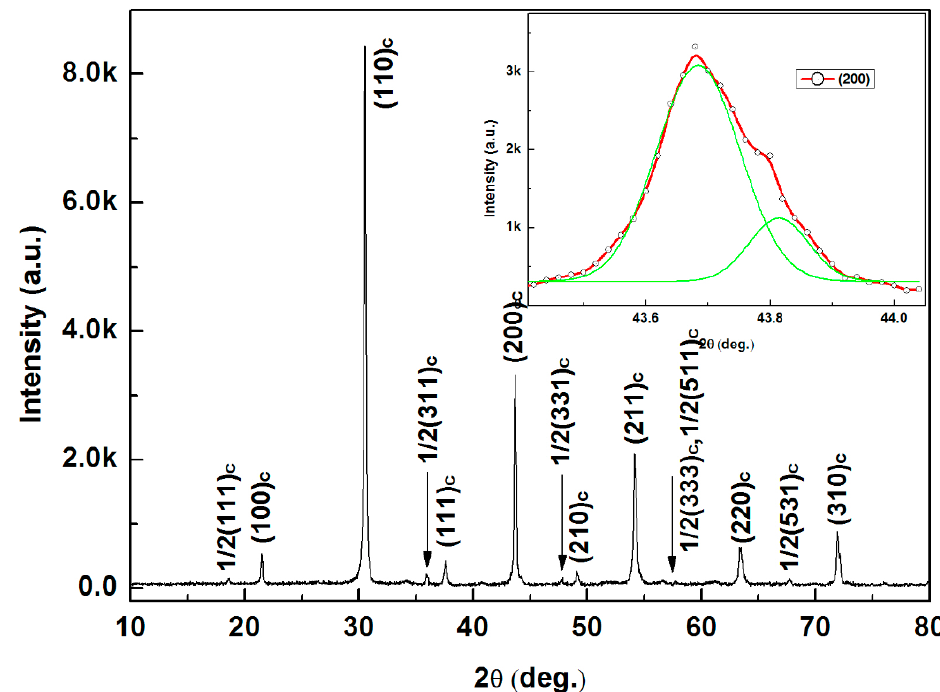
Figure 2. X-ray powder diffraction patterns of the crashed PLN-0.07PT crystal. The insert shows the (200) C peak detail reflections which were fitted by the Gaussian functions.